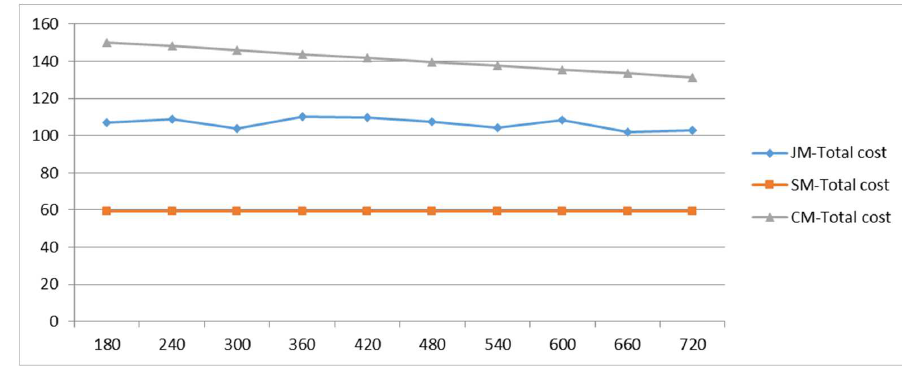
Figure 9. Total cost variations with parameter Δ t .